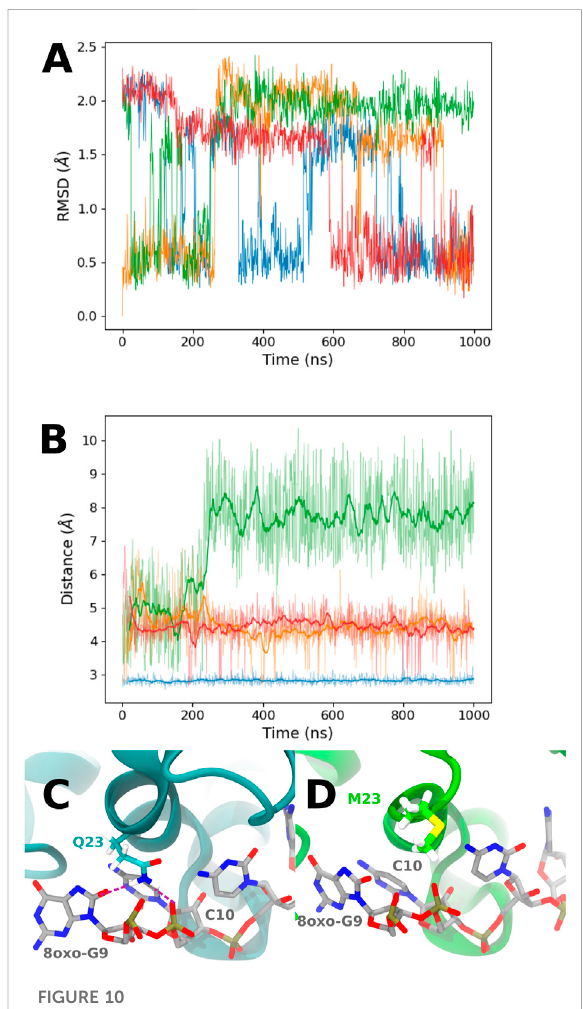
FIGURE 10 (A) RMSDoftheC α atomsofthe49 – 55PCBP1residuesinthe presence of the ° GCCCUG ° G RNA sequence for the different PCBP1mutants:WT(orange),K23Q(blue),K23M(green),andK31D (red). (B) Time evolution of the distance between 8-oxoG9 O8 and K23 N ζ for WT (orange) and K31D mutants (red), 8oxoG9 O8 and Q23 N ϵ for the K23Q mutant (blue), or 8oxoG9 O8 and M23 C ϵ for the K23M mutant. (C) Q23 interaction with 8-oxoG9 O8 and C10 phosphate. Interactions are represented with purple dashed lines. (D) Example of a M23 conformation in the K23M